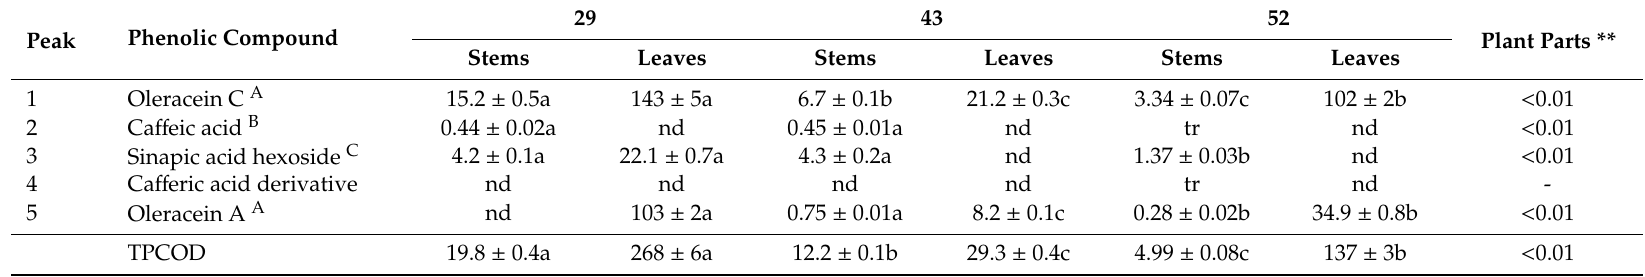
Table 6. Quantification of phenolic compounds and oleracein derivatives in purslane stems and leaves (mg / 100 g dried weight (dw)) in relation to harvesting stage (mean ±